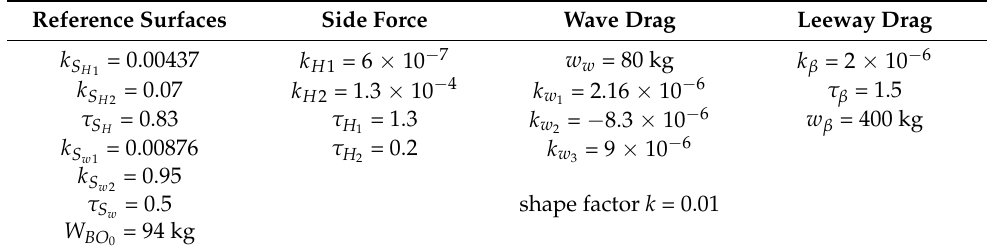
Table 1. Values of the parameters adopted to model the Flyer S demihull forces. Reference